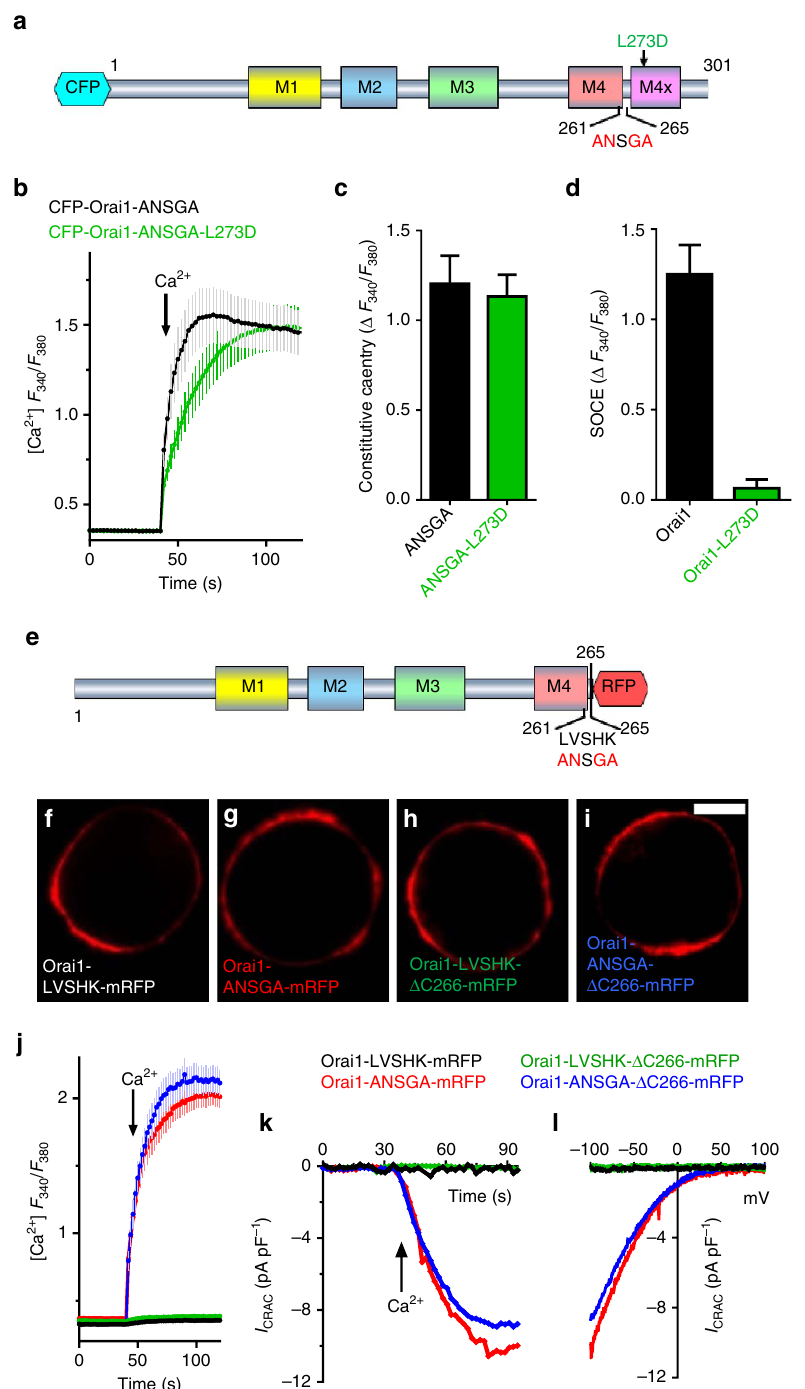
Figure 5 | The open Orai1-ASNGA channel is independent of the C-terminal STIM1-binding site. ( a ) The CFP-Orai1-ANSGA-L273D construct. ( b ) Constitutive fura-2 Ca 2 þ entry responses in store-replete HEK cells expressing CFP-Orai1-ANSGA (black) or CFP-Orai1-ANSGA-L273D (green). ( c ) Summary of the effect of the L273D mutation on constitutive Ca 2 þ entry mediated by CFP-Orai1-ANSGA. ( d ) Summary of the effect of L273D mutation on store-operated Ca 2 þ entry mediated by CFP-Orai1-WT in HEK-STIM1-YFP cells after ionomycin-induced store depletion. ( e ) The Orai1- LVSHK- D C266-mRFP and Orai1-ANSGA- D C266-mRFP truncation constructs. ( f – i ) PM localization of the mRFP-tagged Orai1-WTor Orai1-ANSGA mutant and their D C266 truncations expressed in HEK cells. Scale bar, 5nm. ( j ) Constitutive fura-2 Ca 2 þ entry responses in store-replete HEK cells expressing the mutations in f – i . ( k ) Whole-cell recordings for store-replete HEK cells expressing the mutations in j . ( l ) I – V curves from the same cells as k . All values are means ± obtained using N-terminally CFP-tagged Orai1 truncations, we examined N-terminally CFP-tagged CFP-Orai1-ANSGA ( D 74) and observed an identical partial effect (Fig. 6c,d, blue trace).